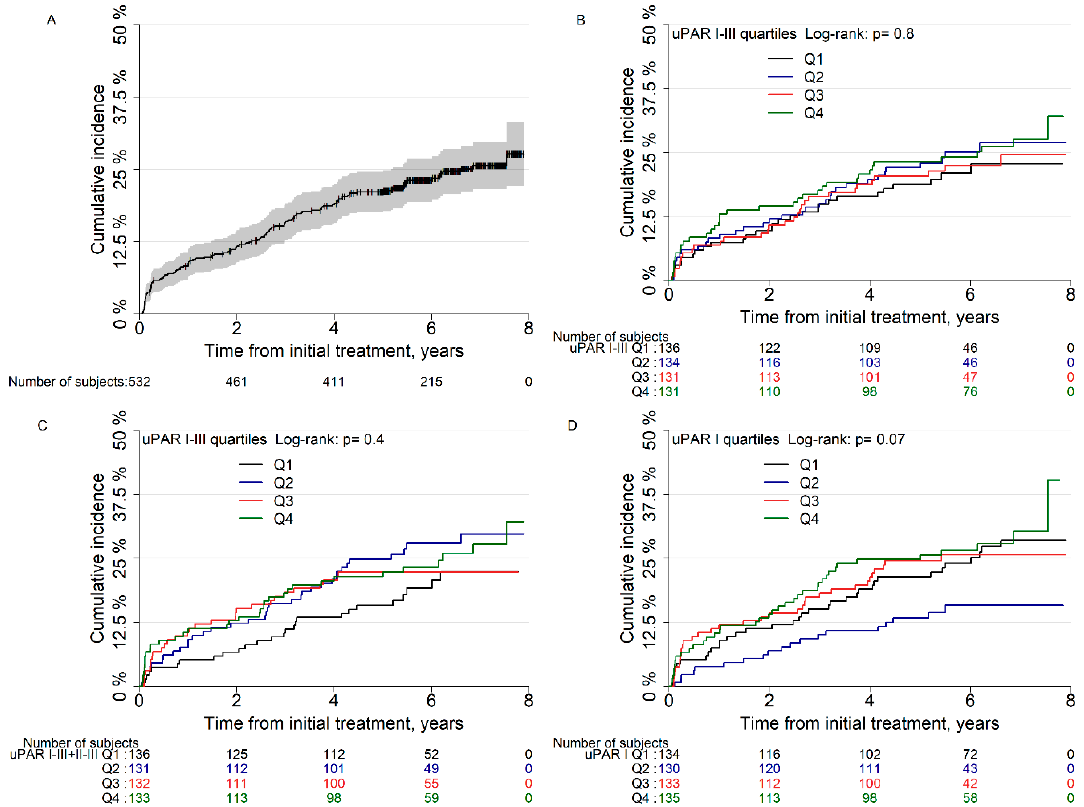
Figure 3. Cumulative incidence of biochemical recurrence after radical prostatectomy in ( A ) all men, ( B ) men stratified for quartiles (Q) urokinase plasminogen activator receptor (uPAR) I–III, ( C ) men stratified for quartiles uPAR I–III + II–III and ( D ) men stratified for quartiles uPAR I. Note that y axis show up to 50% cumulative incidence. Table 2. Uni- and multivariate analysis of biochemical recurrence after radical prostatectomy (N = 532) stratified for plasma urokinase plasminogen activator receptor (uPAR) quartiles. Multivariate analysis was adjusted for age at start of treatment, prostate-specific antigen, pathological Gleason score, margin status, pathological tumor stage and lymph node status. Abbreviations: HR: Hazard ratio; 95%CI: 95% confidence interval; Q: Quartile.